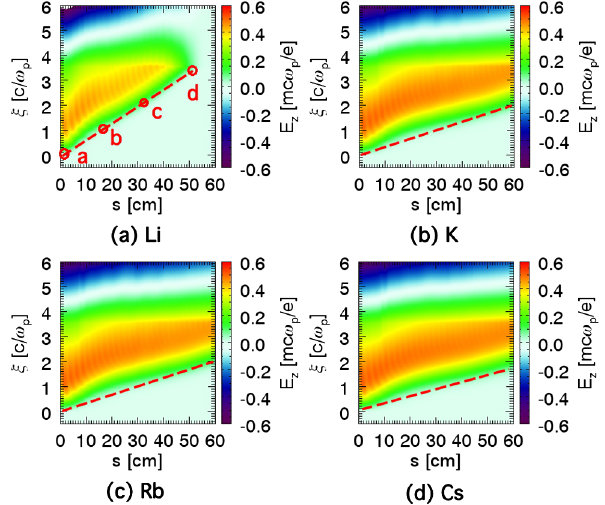
FIG. 4. E z evolution during the beam propagating in different alkaline metal gases. The beam is moving downwards. The four circles in (a) correspond to the positions of the ionization fronts shown in Fig. 3.